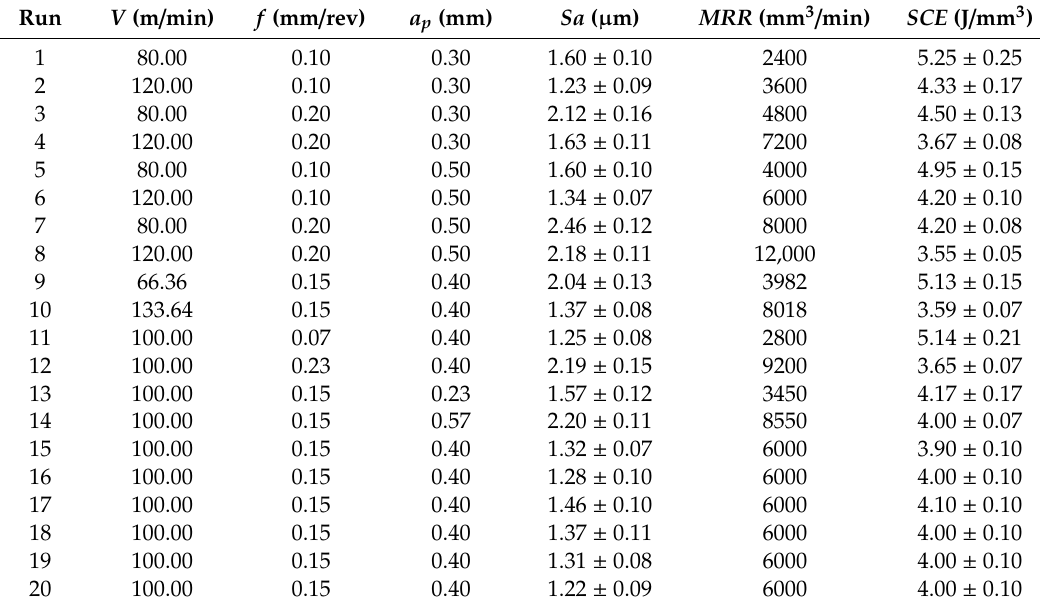
Table 4. Experimental design array and